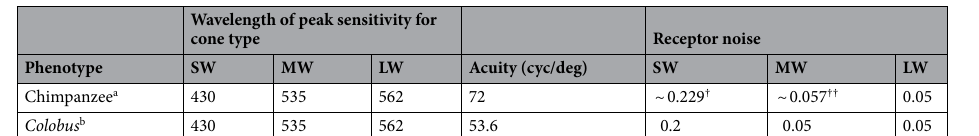
Wavelength of peak sensitivity for cone